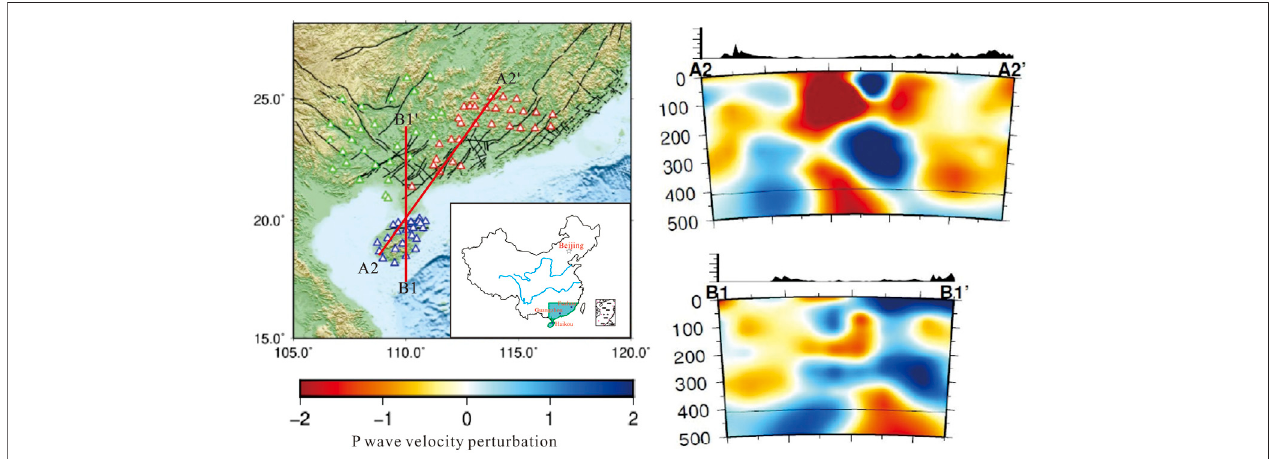
FIGURE 2 | P wave velocity perturbation based on fi nite frequency tomography method. Red triangle-30 mobile station in Guangdong province, green triangle-27 stationary station in Guangxi province, blue triangle-27 stationary station in Guangxi province, A2-A2 ′ and B1-B1 ′ represent NE-SW and N-S orientation sections (modi fi ed from Chen,